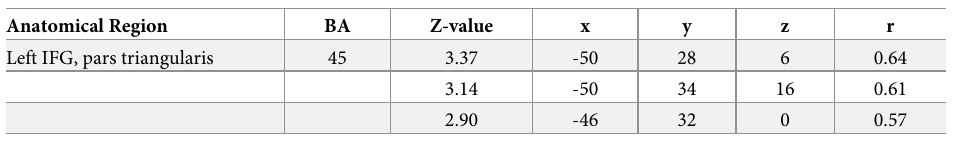
Significant peak activations of exclusion minus inclusion during the Cyberball game at a statistical threshold of p < 0.05 family wise error rate (FWE)-corrected at the voxel level, at cluster extent k > 25. Listed are peak voxels with highest z-values for significant clusters and their local maxima more than 8 mm apart.